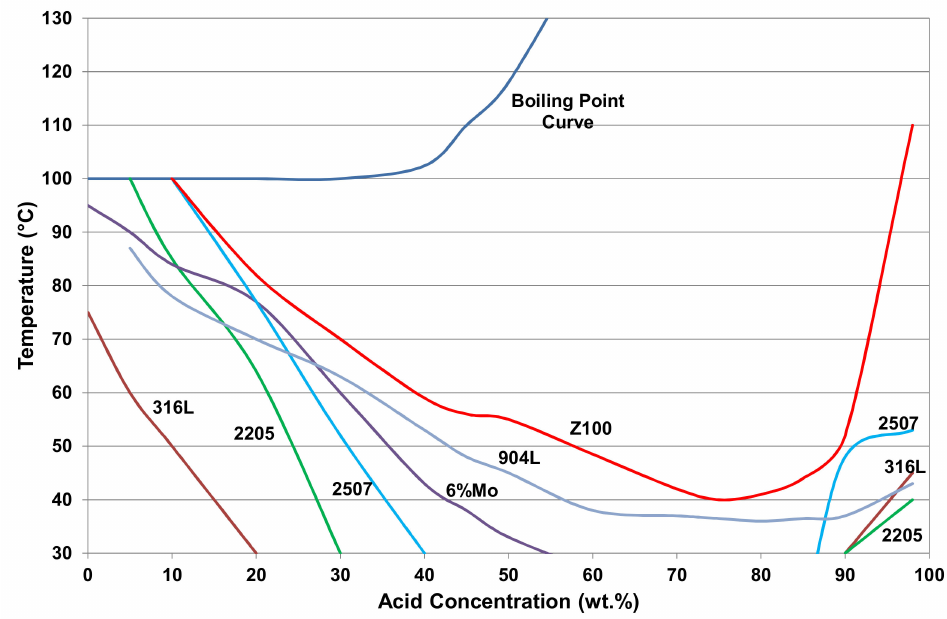
Figure 14. Iso-corrosion curves (0.1 mm/y) for some stainless steels in hydrochloric acid [9]. The inlet temperature was 110 ◦ C and the outlet was 24 ◦ C, while the cooling medium was a brackish water with 320 mg/L chloride at a pH of 8.5. The Z100